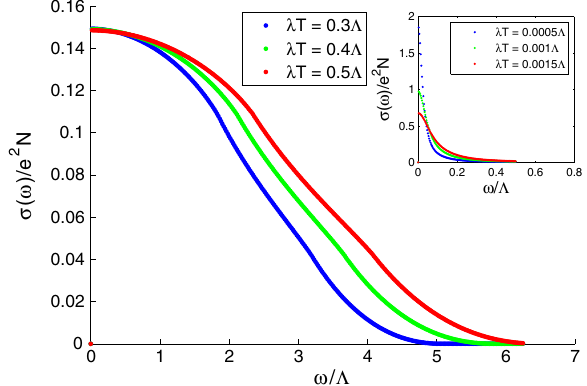
Fig. 5 The optical conductivity σ ( ω ) for several temperatures. ( inset ) For low temperatures ω 0 ≪ T ≪ E F / λ , a distinct Drude peak appears in the spectrum, of width λ T , and the conductivity vanishes for ω > Λ . At high temperatures, the Drude peak is lost, but σ ( ω ) has a clear structure on the scale of ( λ T / ν ) 1/2 ; the optical conductivity has fi nite support over the effective bandwidth ( λ T / ν ) 1/2 ≫ Λ . In this